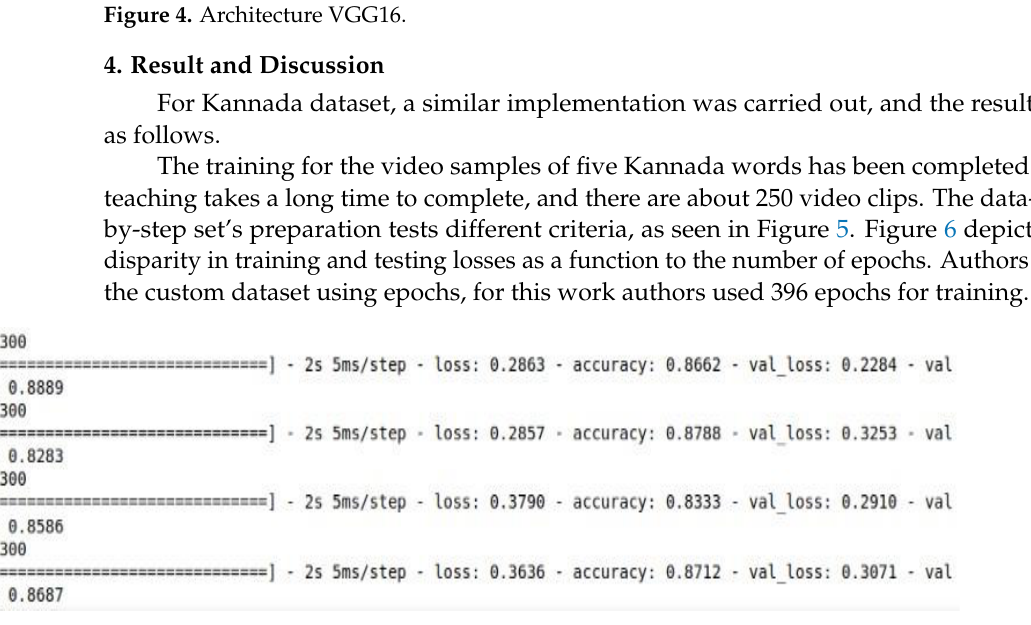
Figure 5. Training of Epochs for five Kannada Words.